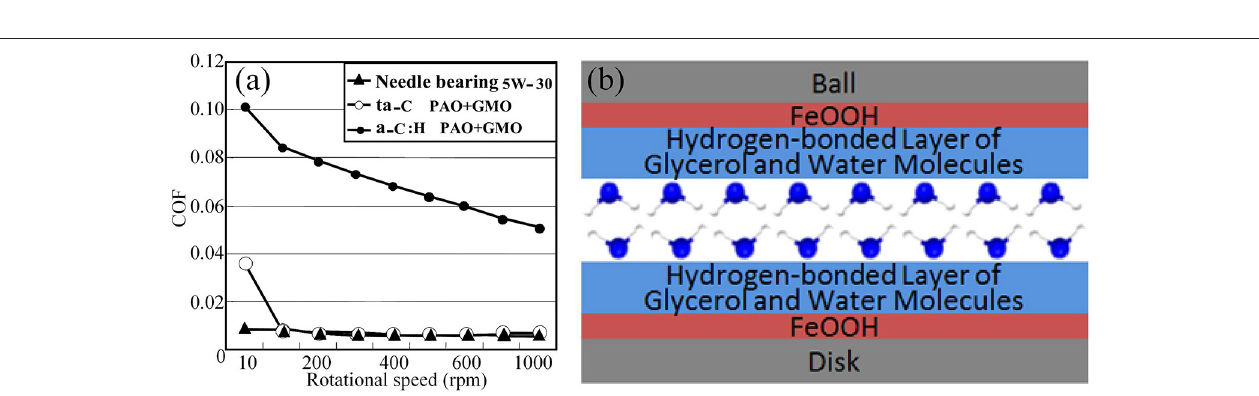
FIGURE 10 | (a) Relationship between the COF and the rotational speed. Bouchet et al. (2007) Copyright 2007, IOP Publishing Ltd. (b) Schematic of the lubrication model and molecular schematic presentation of the hydrogen-bond layer of glycerol and water. Chen et al. (2013) Copyright 2013, American Chemical Society.